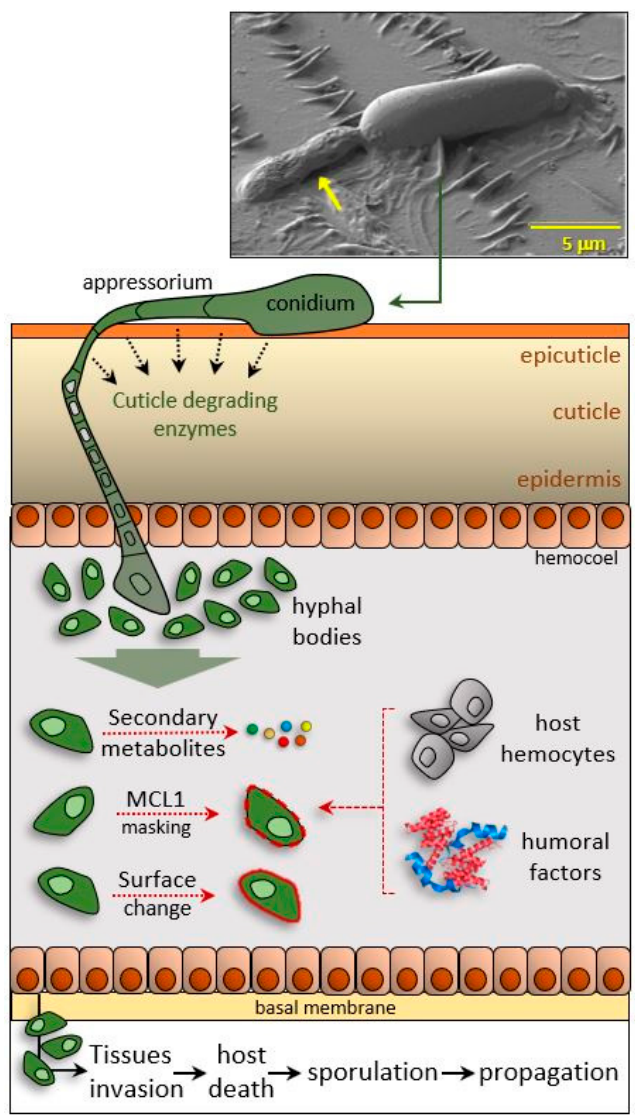
Figure 4. Infection strategies of entomopathogenic fungi. EPF penetrate the insect exoskeleton by means of structures as the appressorium, then hyphal bodies release secondary metabolites and, after surface changes, avoid host immune recognition. SEM micrograph was kindly provided by N.A. Ratcli ff